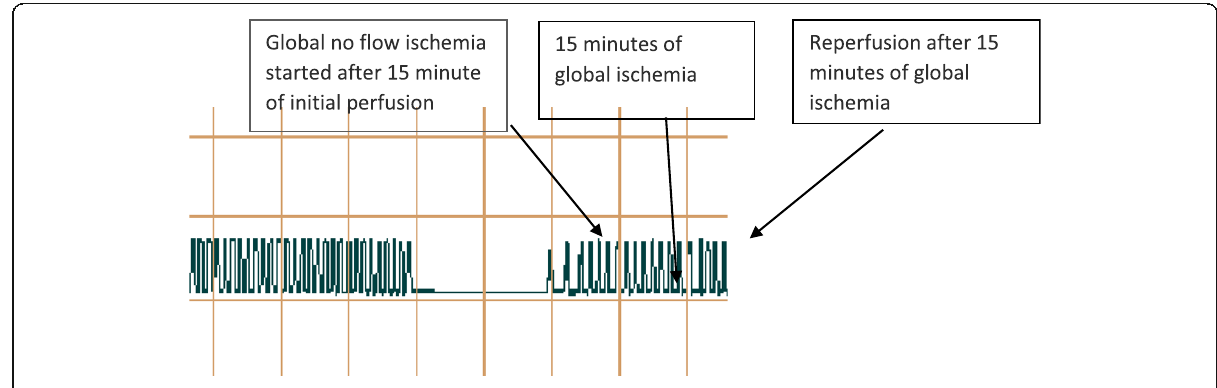
Fig. 7 Tracing on Polygraph of